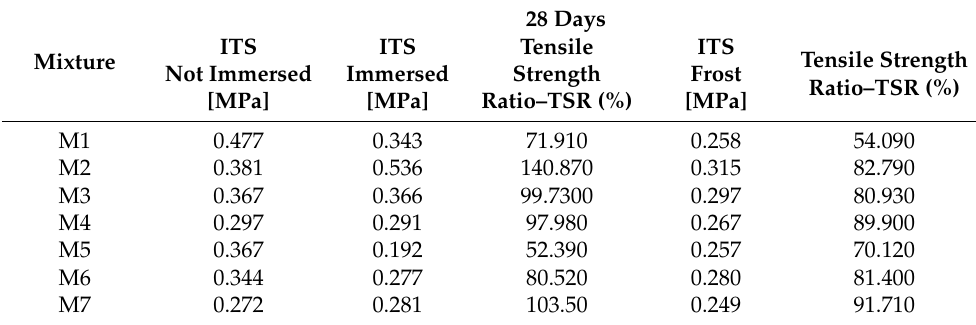
Table 6. Comparison of indirect tensile strength after 28 days of specimens immersed in water and exposed to frost with specimens cured in dry conditions.